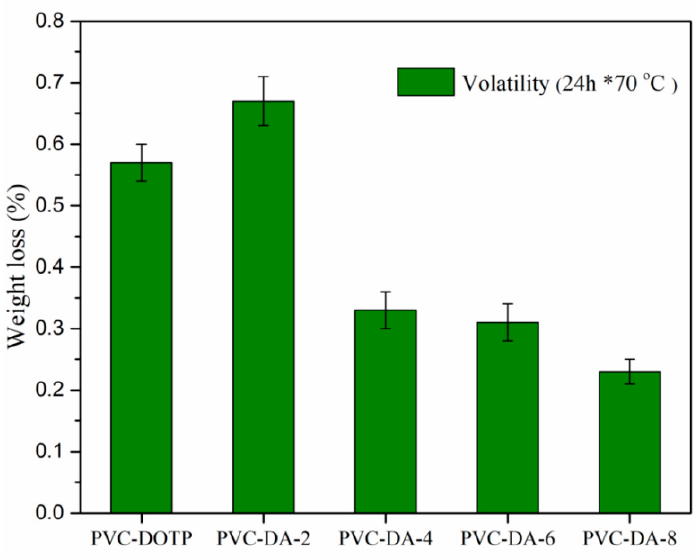
Figure 9. Weight losses of PVC-DA-2n (2n = 2, 4, 6, and 8) and